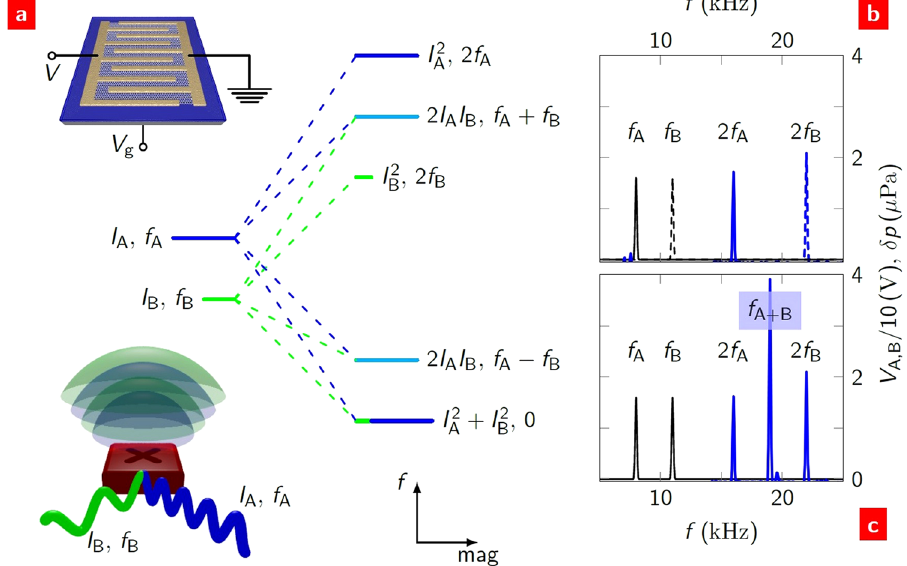
Figure 1. Thermoacoustic generation. ( a ) The sound spectrum (right) resulting from two current sources (left) of differing frequency and amplitude. This is shown schematically in the bottom inset. The frequency and relative magnitude of the sound components are indicated. (The power at each frequency is found by multiplying the relative magnitudes by R /2). The heterodynes (cyan) only exist in the presence of both sources. The transistor is shown in the top inset, with electrodes (gold), 6 mm square monolayer graphene (grey), substrate (blue), and electrical connections (black) to the electrodes and gate. ( b ) Acoustic response (blue) to an ac bias voltage V (black) in a back-gated graphene field-effect transistor. An individual source at frequency f A,B causes a response at the second harmonic 2 f A,B . ( c ) Two frequency sources applied together produce not only the second harmonic responses but also the sum heterodyne frequency at f A + B = 19